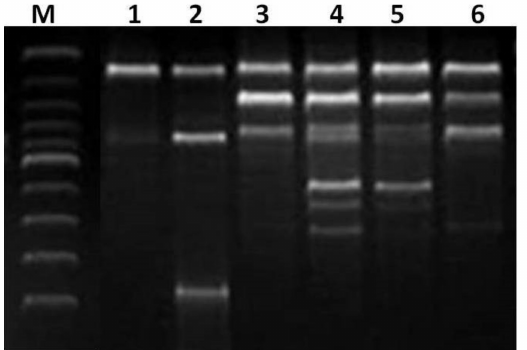
Figure 9. DNA fragmentation of Tyr-Cu(II)-AEEA NPs with a 5–100 µ m/mL concentration in MCF-7 cell line M: 100 Bp DNA ladder; 1: Untreated DNA; 2: 5 µ g/mL treated; 3: 25 µ g/mL treated; 4: 50 µ g/mL treated; 5: 75 µ g/mL treated; 6: 100 µ g/mL